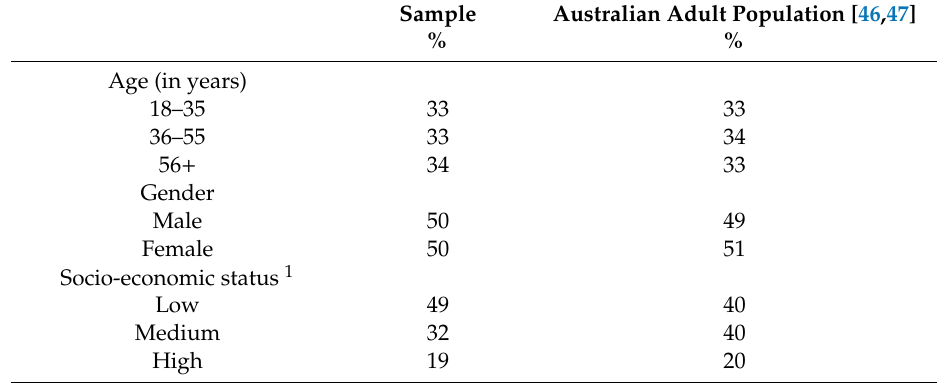
Table 1. Socio-demographic characteristics of the study sample compared to the Australian adult population ( n =